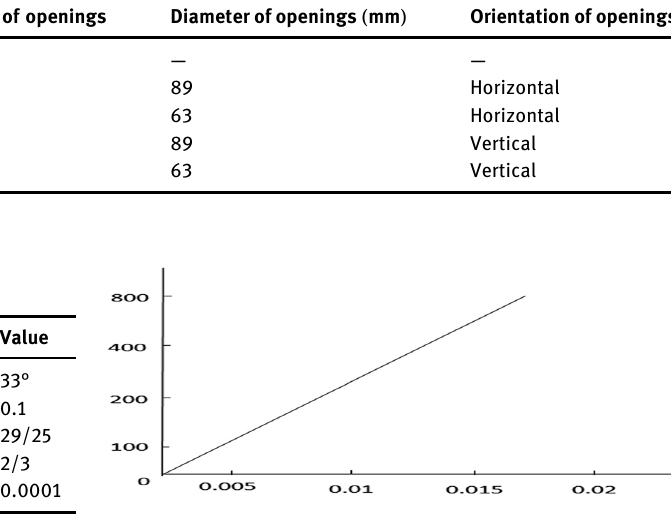
Figure 3: GFRP stress – strain constitutive